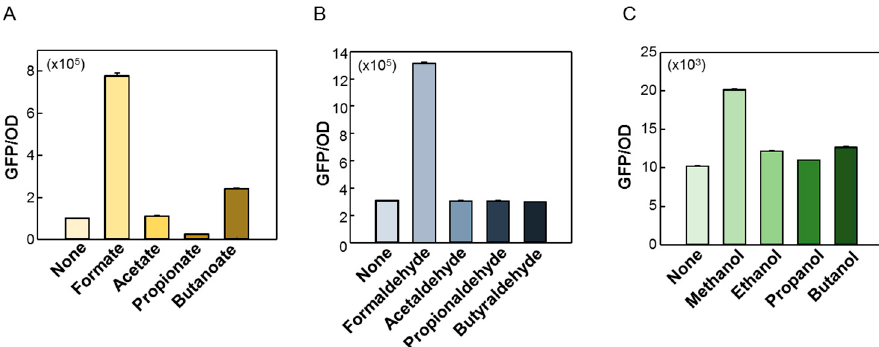
Figure 4. Substrate specificity of the C1 biosensors. ( A ) C1–C4 acids ( B ), aldehydes, and ( C ) alcohols were administered to the respective biosensor cells, and the fluorescence response signals were